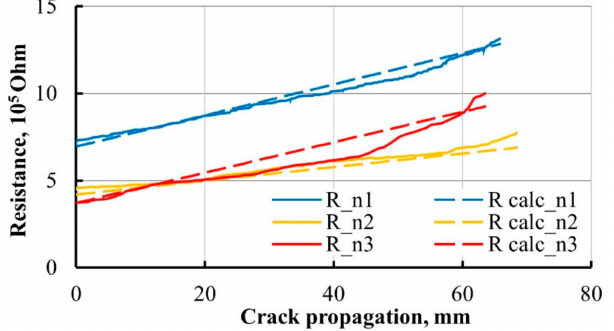
Figure 18. Experimental (solid line) and calculated (dashed line) electrical resistance of MWCNT- modified 8-layered GFRP composite DCB during Mode I interlaminar fracture toughness test.